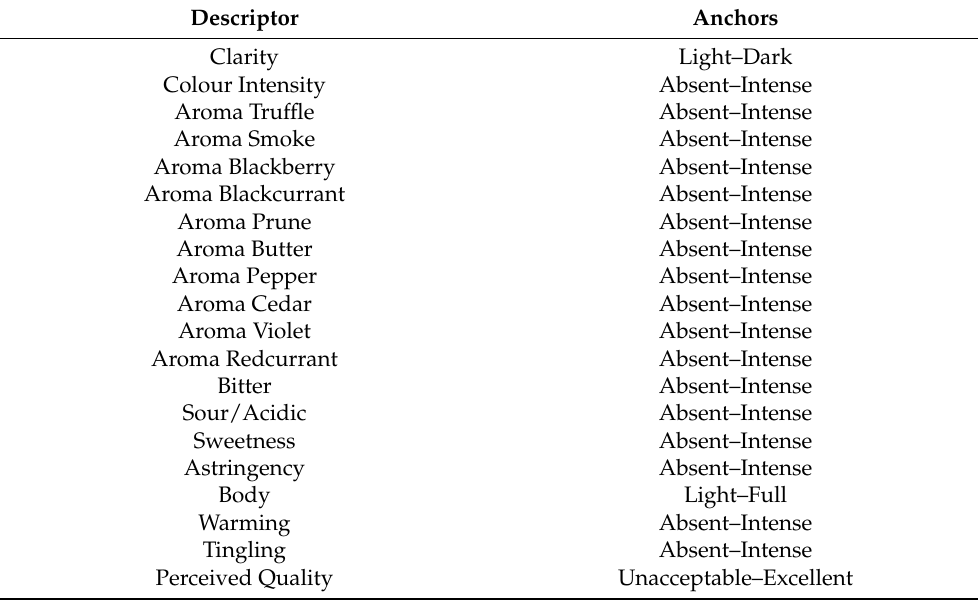
Table 2. Sensory descriptors evaluated and anchors used during sensory